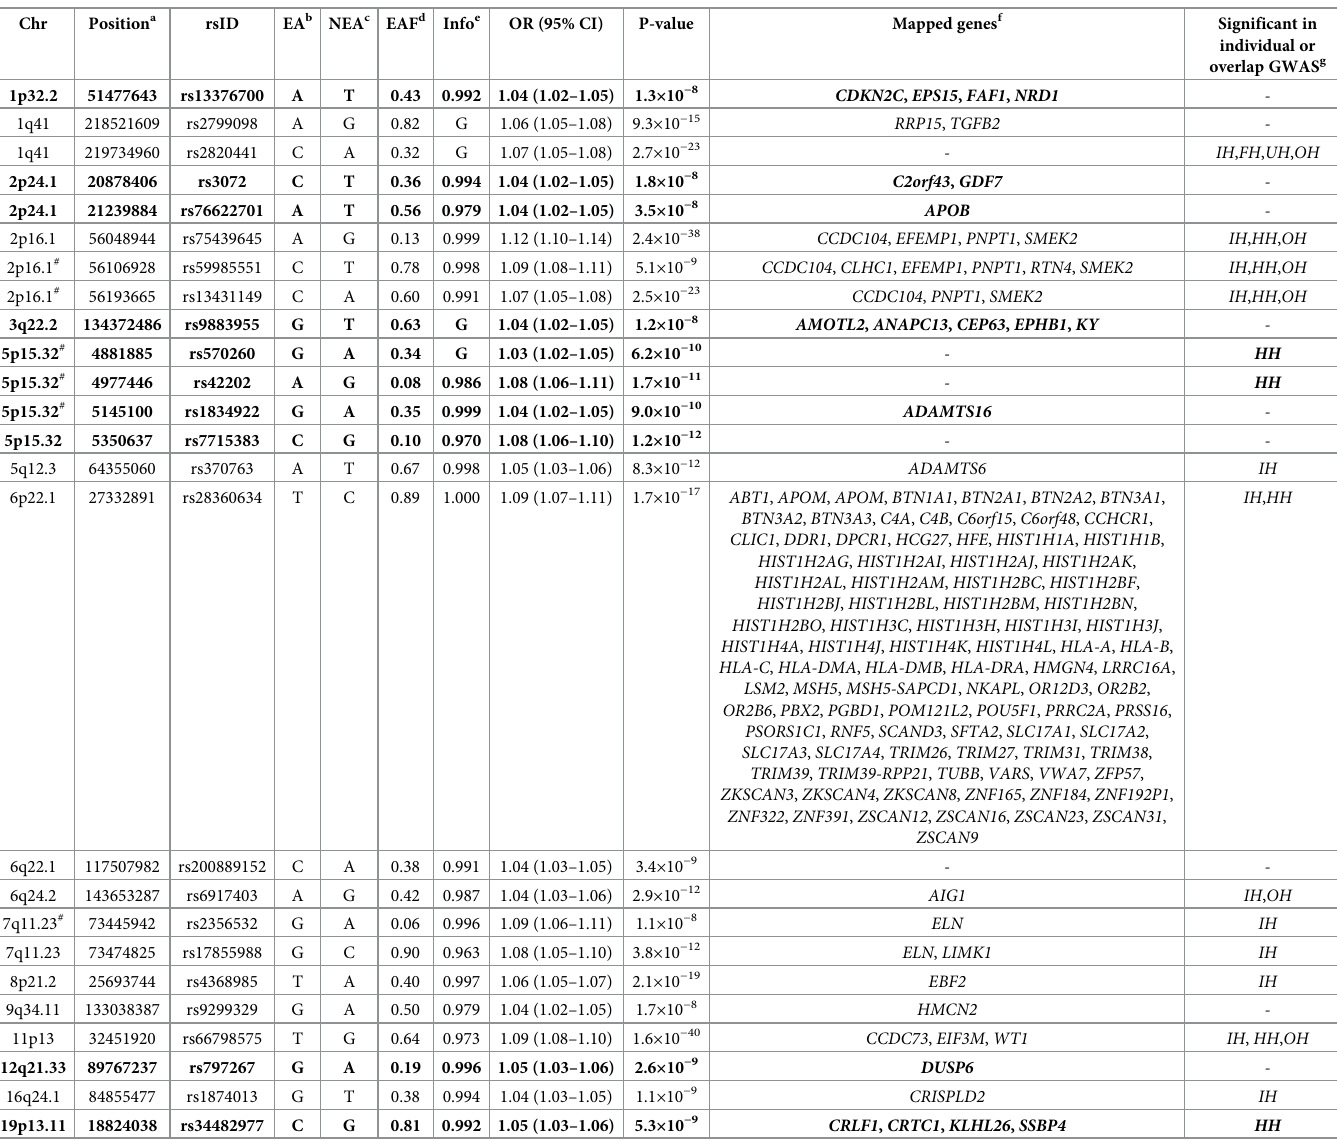
Table 3. Nineteen loci (twenty-five signals) significantly associated in the umbrella hernia